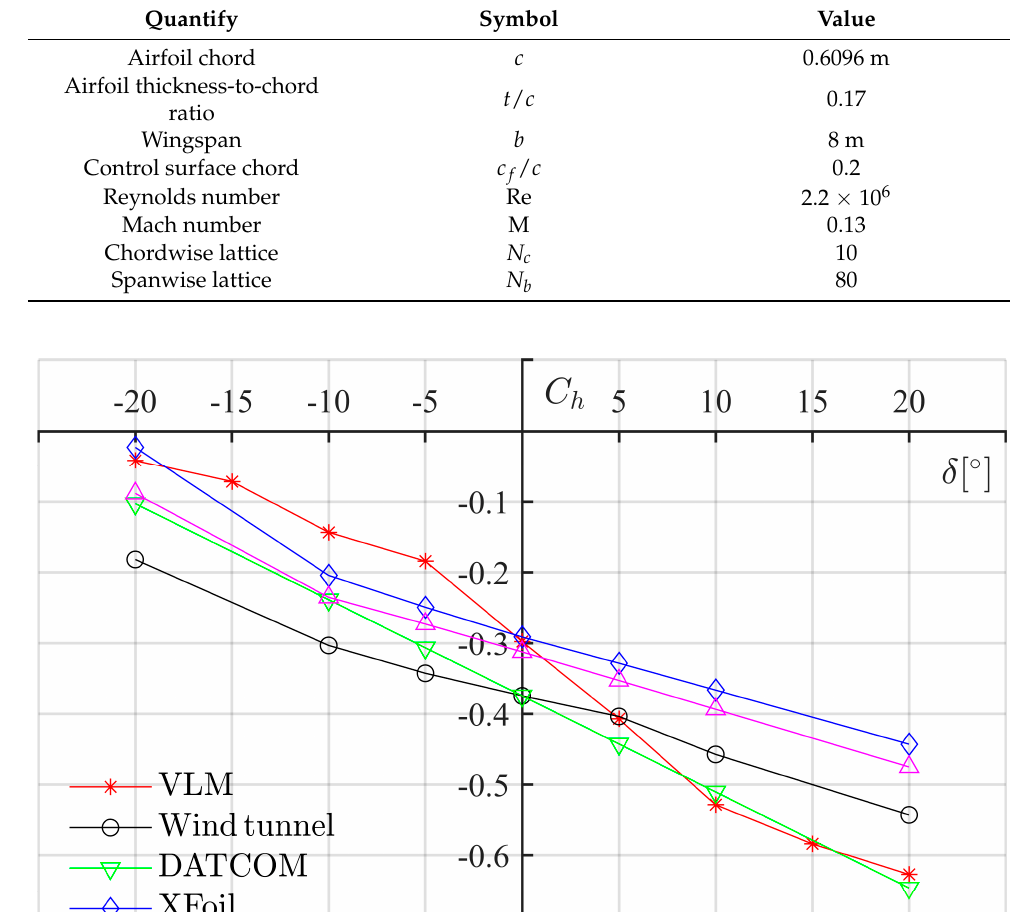
Table A1. Reference quantities and flow conditions.